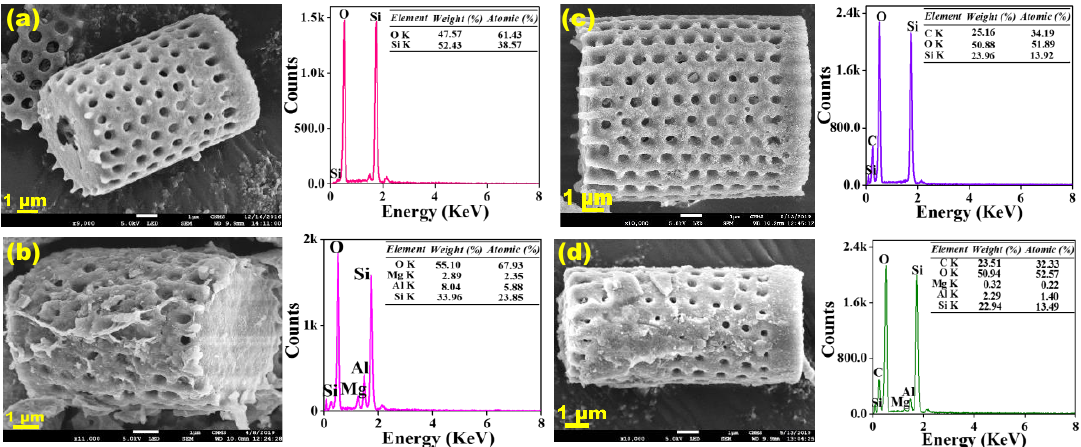
Figure 2. Field emission scanning electron microscopy-energy-dispersive X-ray spectroscopy (FESEM-EDX) images of before adsorption ( a ) DE, ( b ) DE-LDH and after dye adsorption ( c ) DE-Congo Red (CR) and ( d )